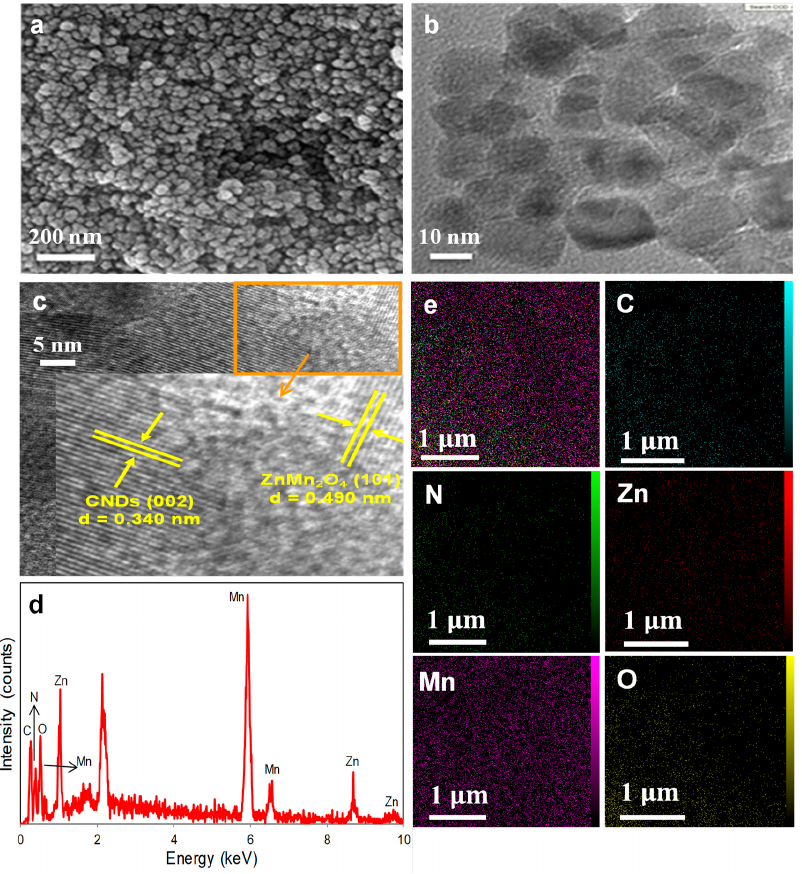
Figure 2. ( a ) SEM, ( b ) TEM, and ( c ) HRTEM images. ( d ) EDX spectrum and ( e ) EDX mapping of CNDs/ZnMn 2 O 4 (20%) nanocomposite. Figure 3 shows the oxidation states of the elements in the CNDs/ZnMn 2 O 4 (20%) nanocomposite as per XPS analysis. The survey spectrum consisted of the peaks related to C 1s, N 1s, Zn 2p, Mn 2p, and O 1s. The narrow scan of carbon was completed in the 283–292 eV region and produced two dominant peaks, which were deconvoluted into three peak components at binding energies (B.E) of 284.7, 285.5, and 288.5 eV, which were, respectively, associated with the sp 2 graphitic carbon (C–C), sp 2 aromatic C at- tached to –NH 2 , and the carbon corresponded to heptazine/triazine C-N-C coordination (Figure 3b) [24]. The N 1s spectrum generated in the corresponding narrow scan was deconvoluted into four peak components positioned at 398.5, 399.1, and 400.5 eV (Figure 3c), which correspond to the nitrogen as sp 2 -hybridized (C=N-C), tertiary form (N–(C) 3 ) and hydrogen-bonded (C–N–H) , respectively [24]. The Zn 2p high-resolution spectrum produced two peaks at B.E. of 1043.6 eV and 1020.5 eV, respectively, matched with Zn 2p 1/2 and Zn 2p 3/2 and indicated the existence of Zn element in +2 oxidation state (Figure 3d) [32]. On the other hand, the Mn 2p narrow scan generated two strong peaks, one as- sociated with Mn 2p 3/2 centered at binding energy of 641.8 eV and the other one ascribed to Mn 2p 1/2 at 653.4 eV (Figure 3e) [32]. The O 1s spectrum deconvolution resulted in three